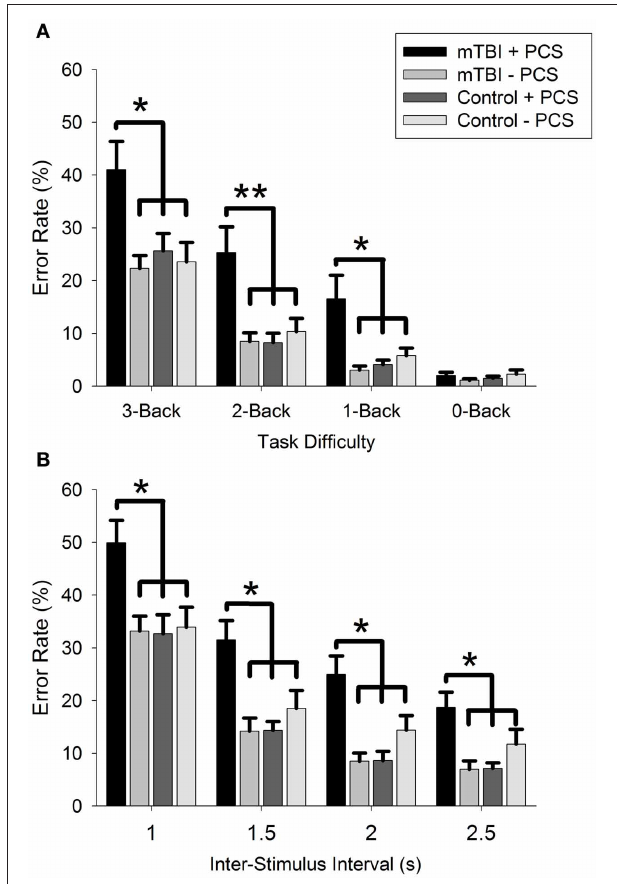
FIGURE 2 | Reaction Time for (A): n-Back and (B): PVSAT